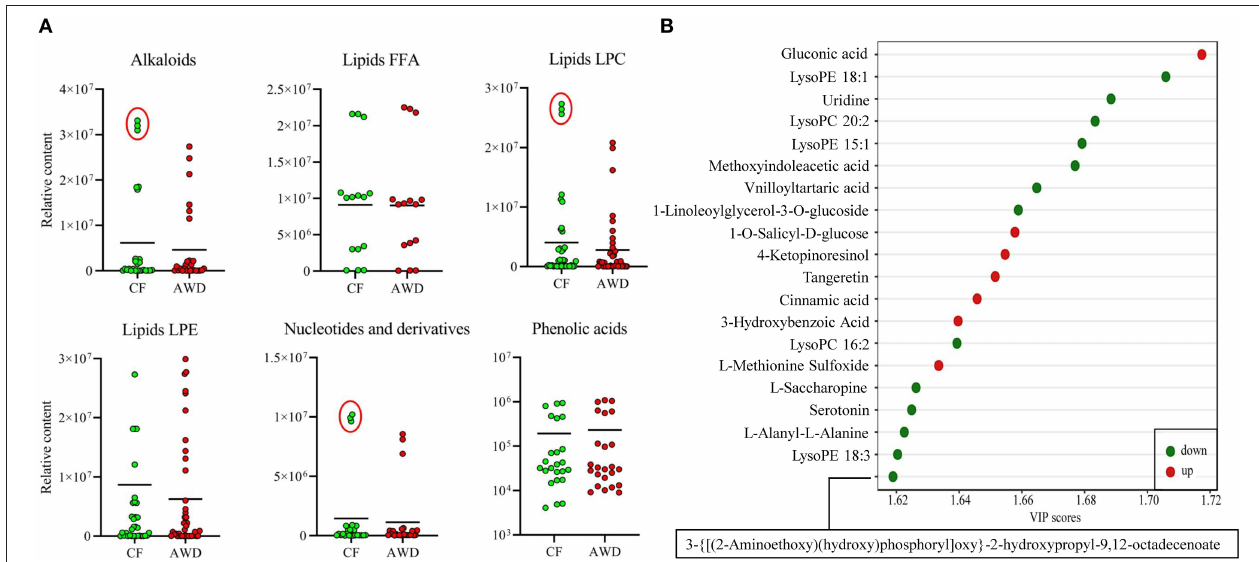
FIGURE 4 | Relative contents of differentially accumulated metabolites in AWD vs. CF. (A) Relative content values of upregulated or downregulated metabolites were plotted for the metabolite groups that showed distinct clustering pattern in Figure 3A hierarchical clustering such as alkaloids, lipids, nucleotides, and phenolic acids between AWD and CF irrigation types. (B) Different metabolites in OPLS-DA model with top 20 VIP values in AWD vs. CF comparison.